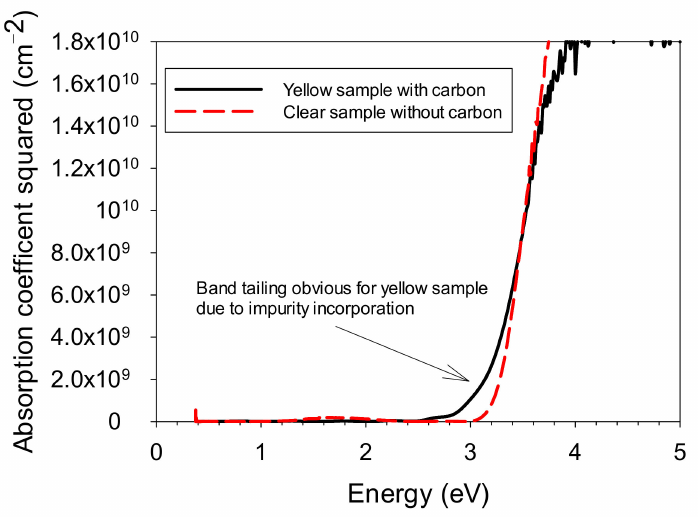
Figure 13. Absorption coefficient squared data for the two samples of Figure